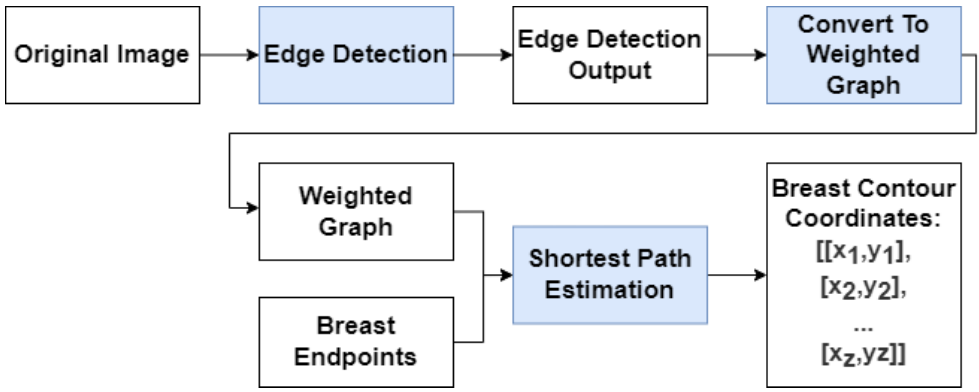
Figure 2. Diagram of the Breast Contour Detection